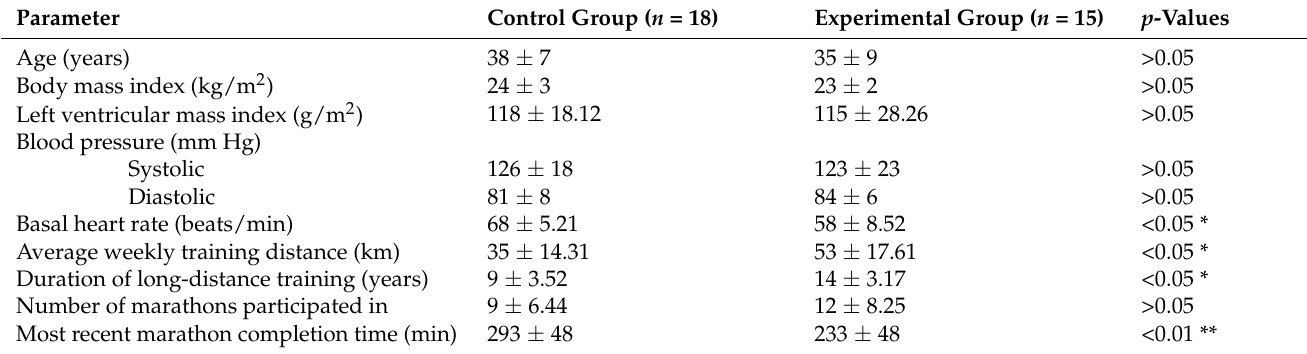
Table 1. Baseline parameters of amateur marathon runners in Hengyang (mean ± standard